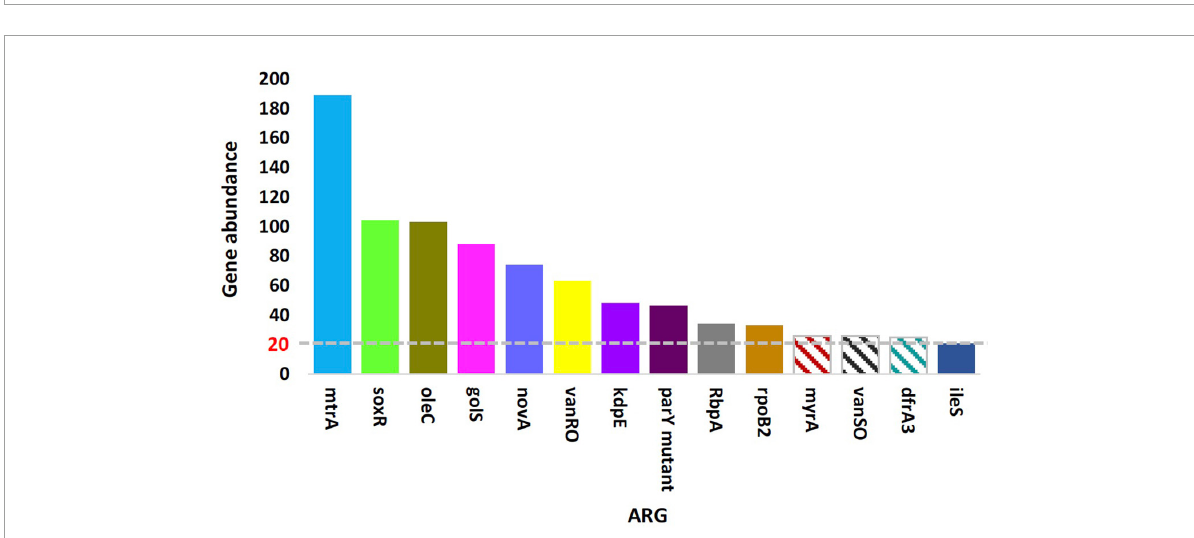
FIGURE2 Means of the top highly abundant antibiotic resistance genes ( > 20 ORFs/ARG) across type of microbiome surrounding Moringa oleifera. Patterned columns refer to ARGs whose numbers of ORFs in bulk soil samples are non-homogeneous. Box colors of other ARGs match those of Figure 4